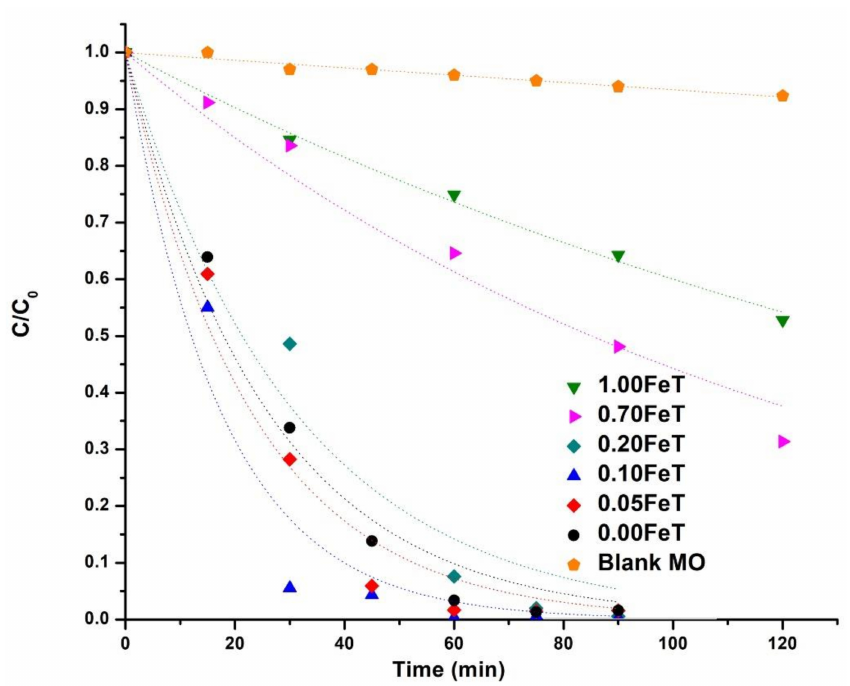
Figure 5. Photocatalytic e ffi ciency of the synthesized